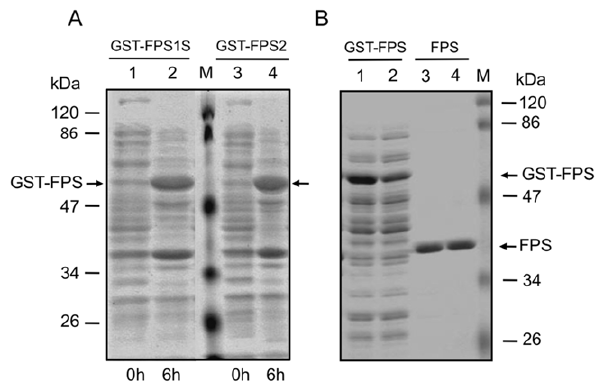
Figure 1. Expression in E.coli and purification of recombinant FPS1S and FPS2 proteins. (A) Total protein extracts from E. coli cells harbouring either pGEX-3X-NotI-FPS1 or pGEX-3X-NotI-FPS2 before (lanes 1 and 3) and after induction (lanes 2 and 4) of GST-FPS1S and GST-FPS2 expression with 0.4 mM IPTG for 6 hours at 22 u C. (B) Soluble protein extracts of IPTG-induced E. coli cells harbouring either pGEX-3X- NotI-FPS1 (lane 1) or pGEX-3X-NotI-FPS2 (lane 2), and purified native FPS1S (lane 3) and FPS2 (lane 4) protein preparations after Glutathione- Sepharose 4B affinity column chromatography, proteolytic digestion with Factor Xa and protease removal. Arrows indicate the position of GST-FPS protein fusions and purified native FPS proteins. Molecular masses of standards (M) are indicated in kDa.